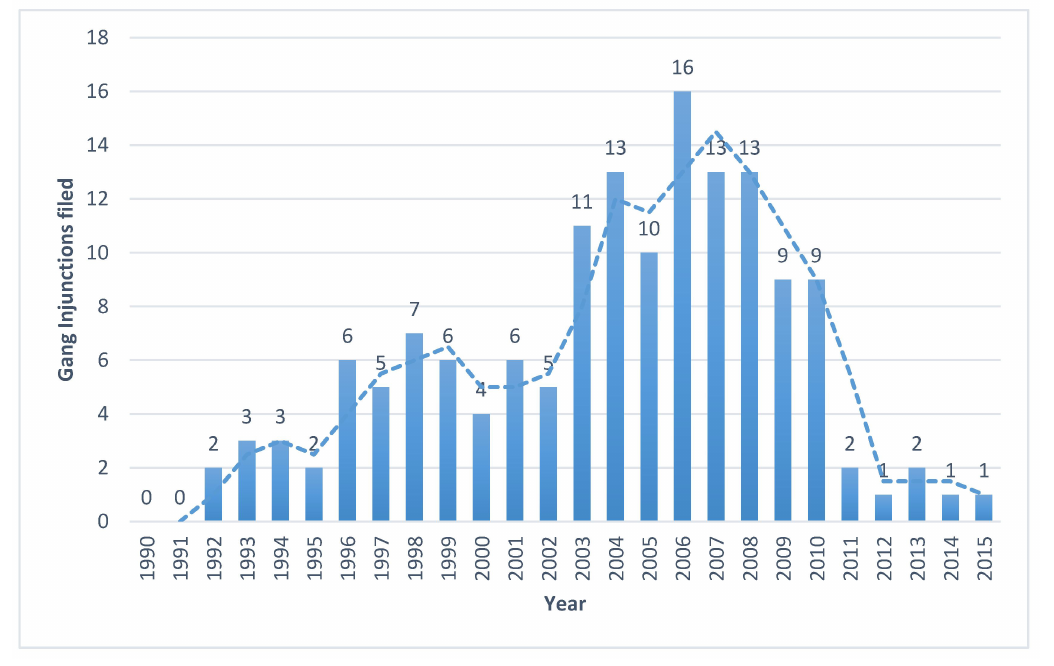
Figure 8. Civil gang injunctions in California (1990–2015): active, dismissed and overruled injunctions (Source: James O’Neil Spady, courtesy of Scott, ‘What the community